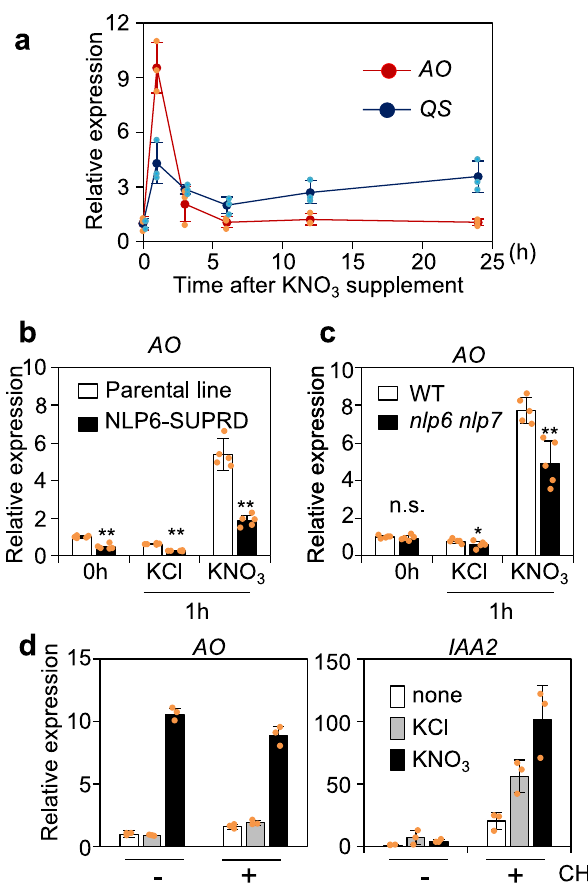
Fig. 1 Nitrate-inducible expression of AO . a Time-course analysis of AO and QS expression after supplementation of KNO 3 at the fi nal concentration of 10 mM. Nitrate induction of expression of AO in NLP6-SURRD transgenic seedlings and the parental genotype ( b ), and in the wild-type (WT) and nlp6 nlp7-1 double mutant seedlings ( c ). Asterisks indicate signi fi cant differences (Welch ’ s t -test; * P ≤ 0.05, ** P ≤ 0.01). d Nitrate-induced expression of AO in plants treated with cycloheximide (CHX). In ( a ), 4-day- old WT seedlings were treated with 10 mM KNO 3 for the indicated time period. In ( b – d ), seedlings were treated with 10 mM KNO 3 or KCl (control) for 1 h. In ( d ), seedlings were treated with 100 µ M CHX for 1 h before nitrate or control treatment. IAA2 was used as a positive control gene for the CHX treatment. All seedlings were grown under continuous light. Data represent mean ± standard deviation [SD; n = 3 in ( a , d ) and n = 5 in ( b , c